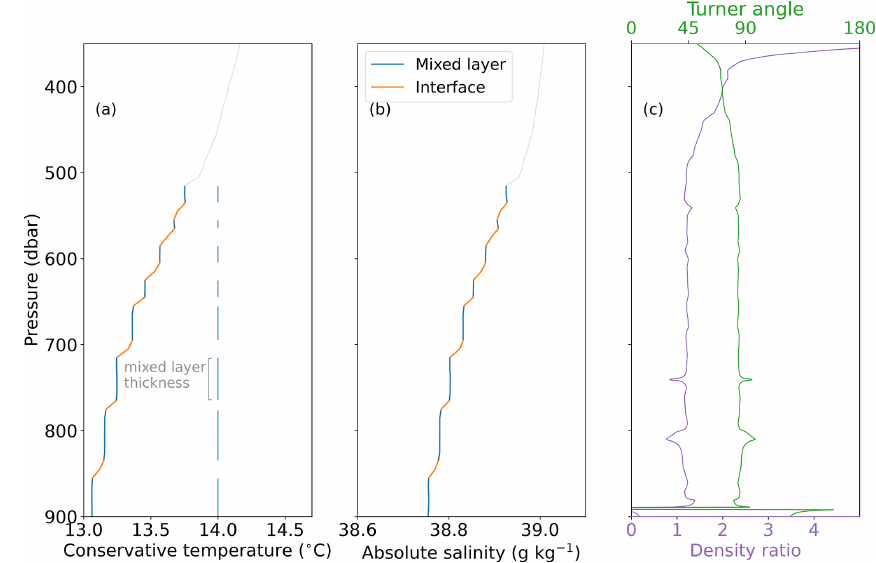
Figure 1. Example thermohaline staircase from Argo float 6901769 at 37.9 ◦ N, 8.9 ◦ E in the Mediterranean. Grey line is 1dbar averaged temperature (a) and salinity (b) , with blue and orange lines marking the mixed layers and interfaces of the staircase. (c) Corresponding profiles of Turner angle and density